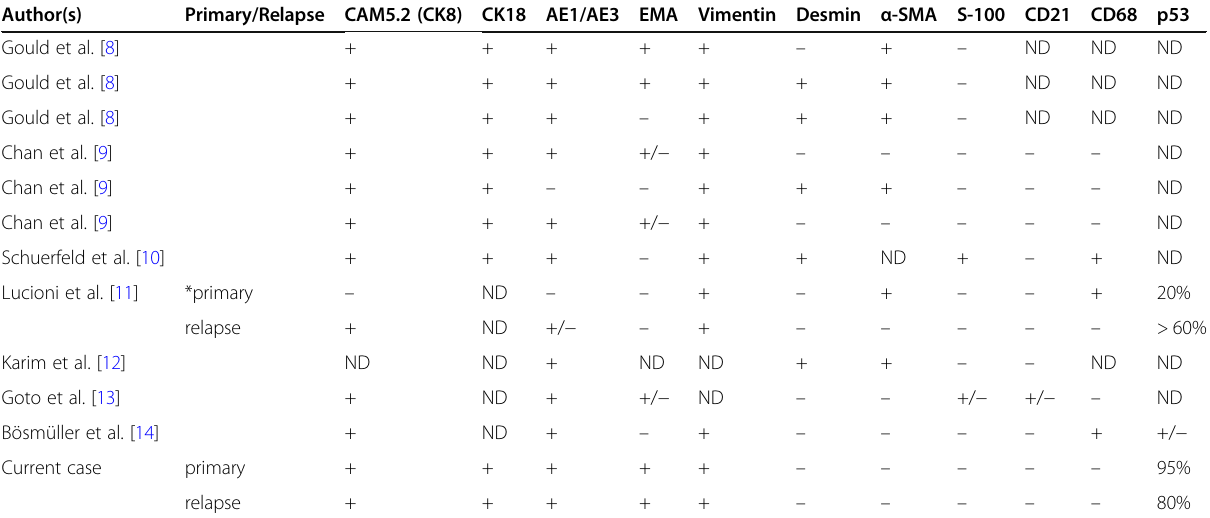
Table 3 Immunohistochemical results of published CIRC tumors